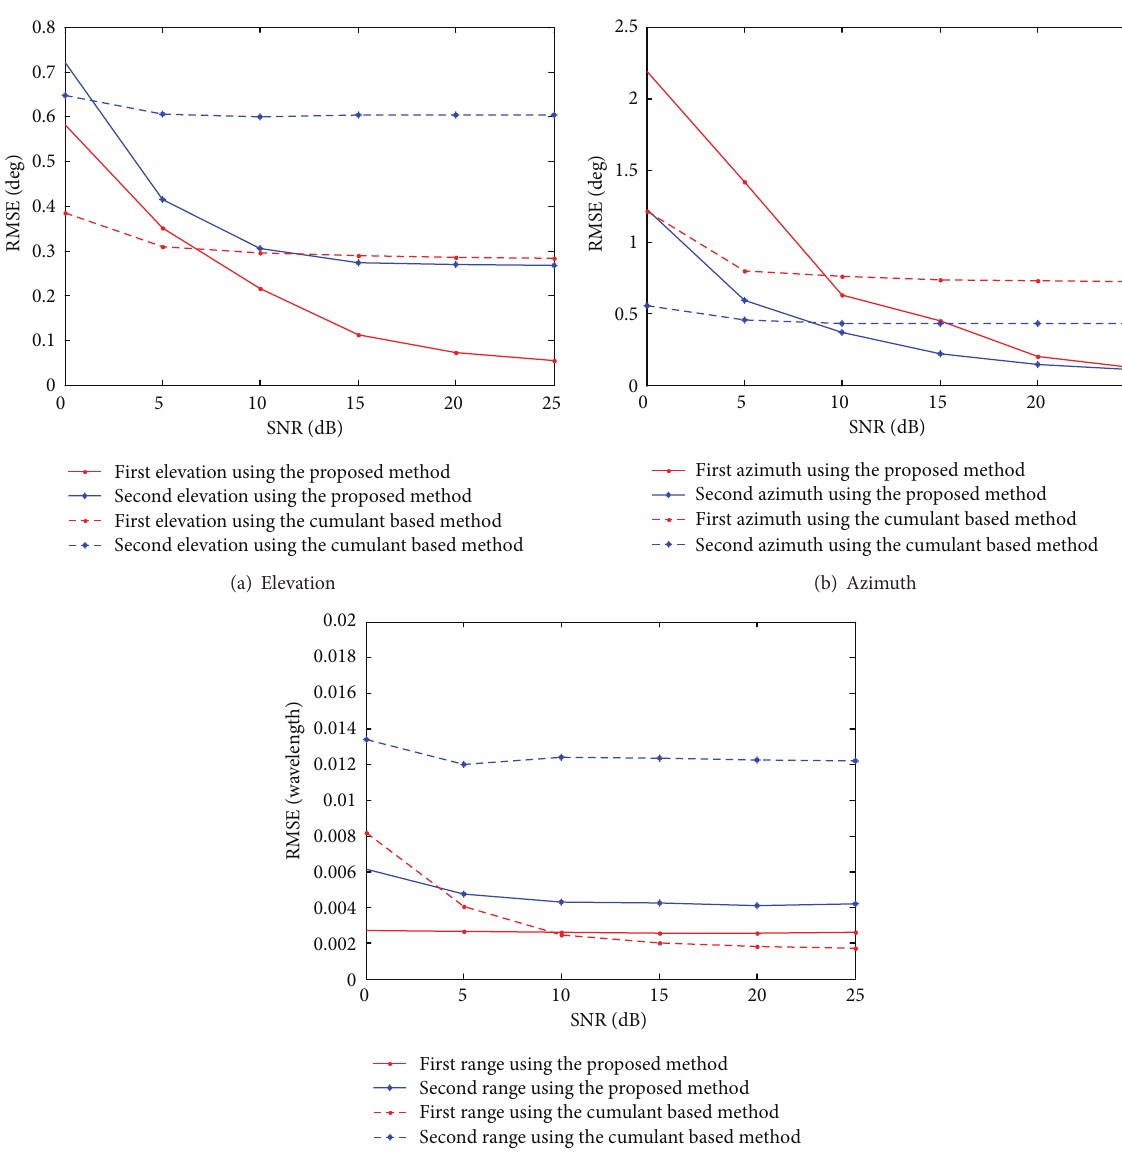
Figure 2: The RMSEs of the elevation, azimuth, and range estimation using the proposed method and the fourth-order cumulant based method versus SNRs.